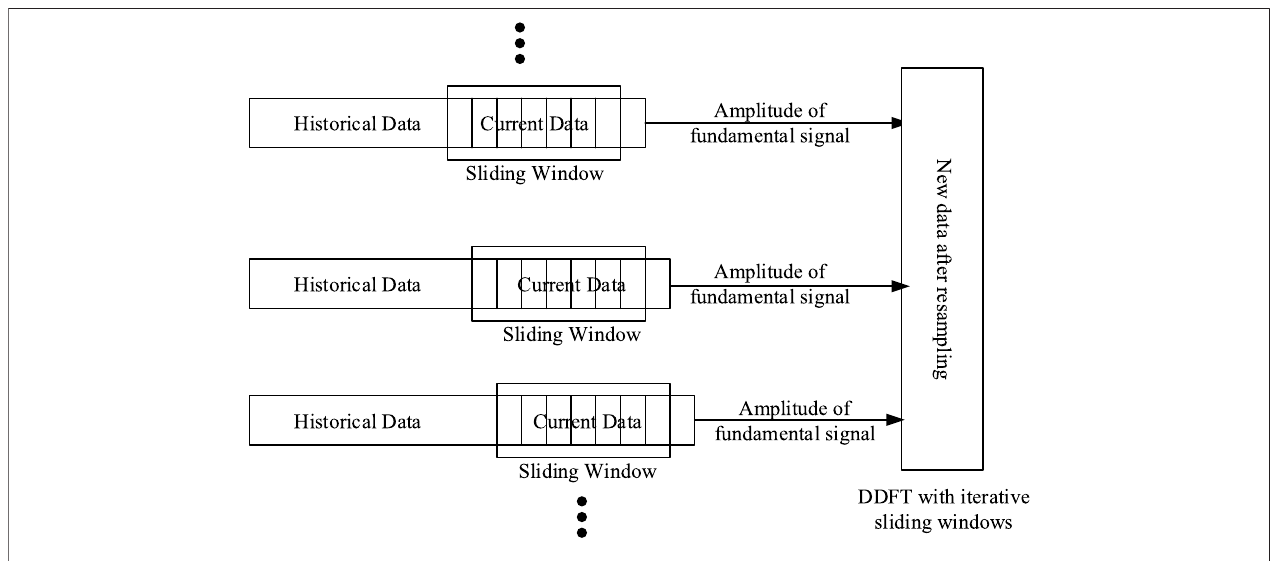
FIGURE 2 | The technological fl ow of double discrete Fourier transform algorithm.